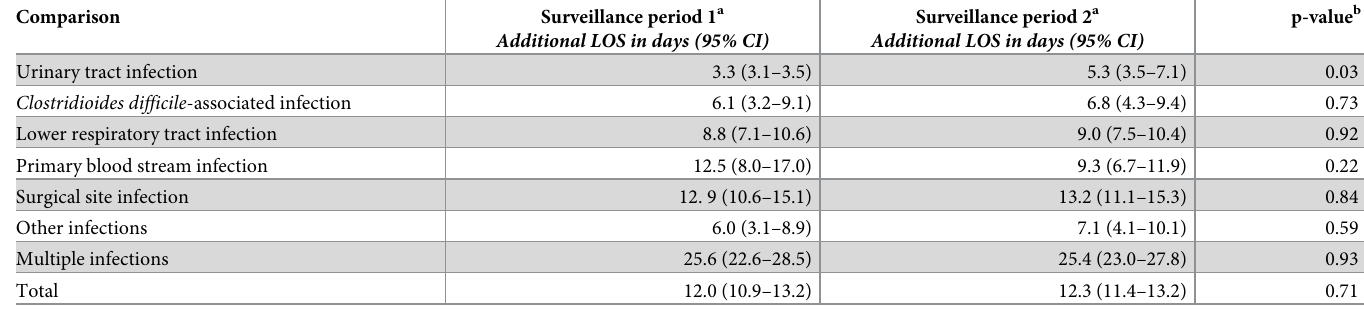
Table 2. Model approach I: Results of additional length of stay estimates from the multistate model stratified by infection site/type and surveillance period.